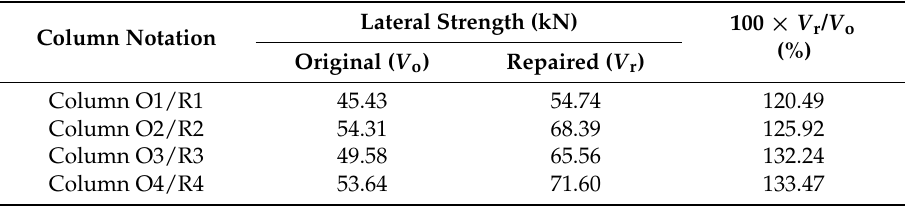
Table 10. Comparison of